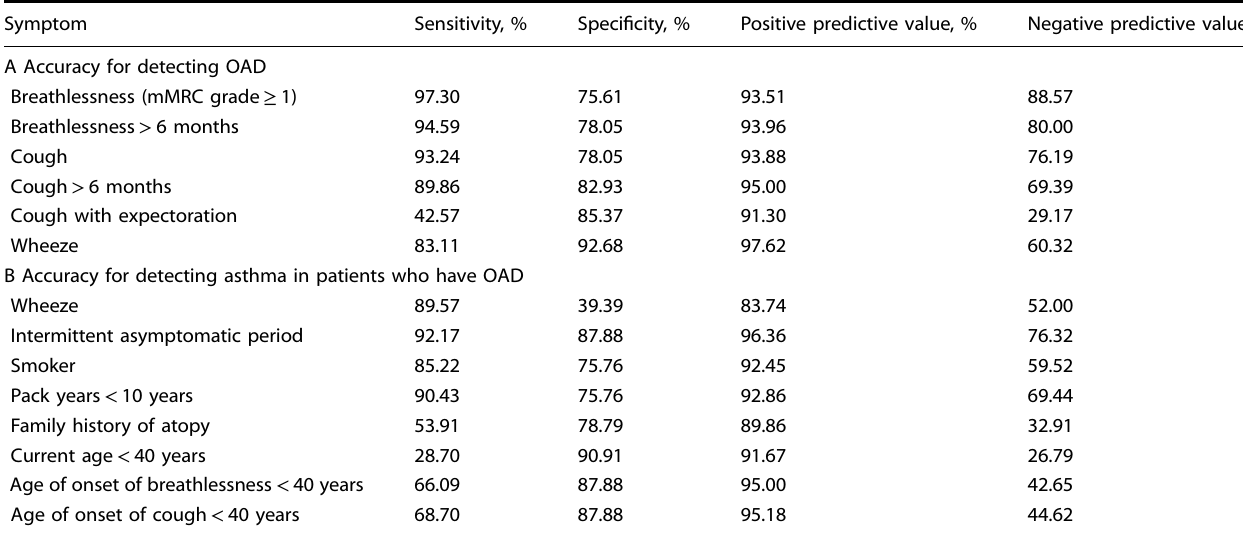
Table 2. Accuracy of each symptom (A) for detecting OAD and (B) for detecting asthma in patients who have OAD